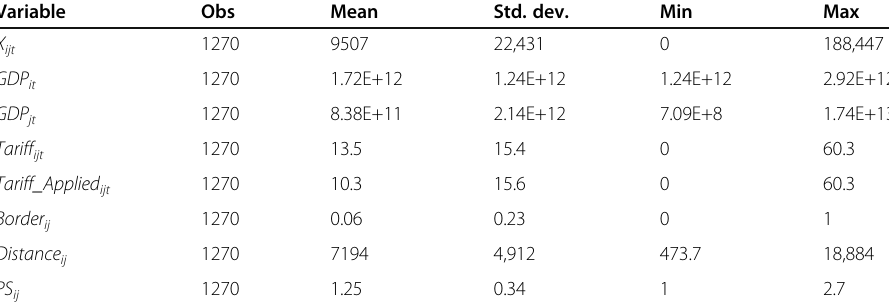
Table 1 Summary statistics of variables used in the gravity equation Variable Obs